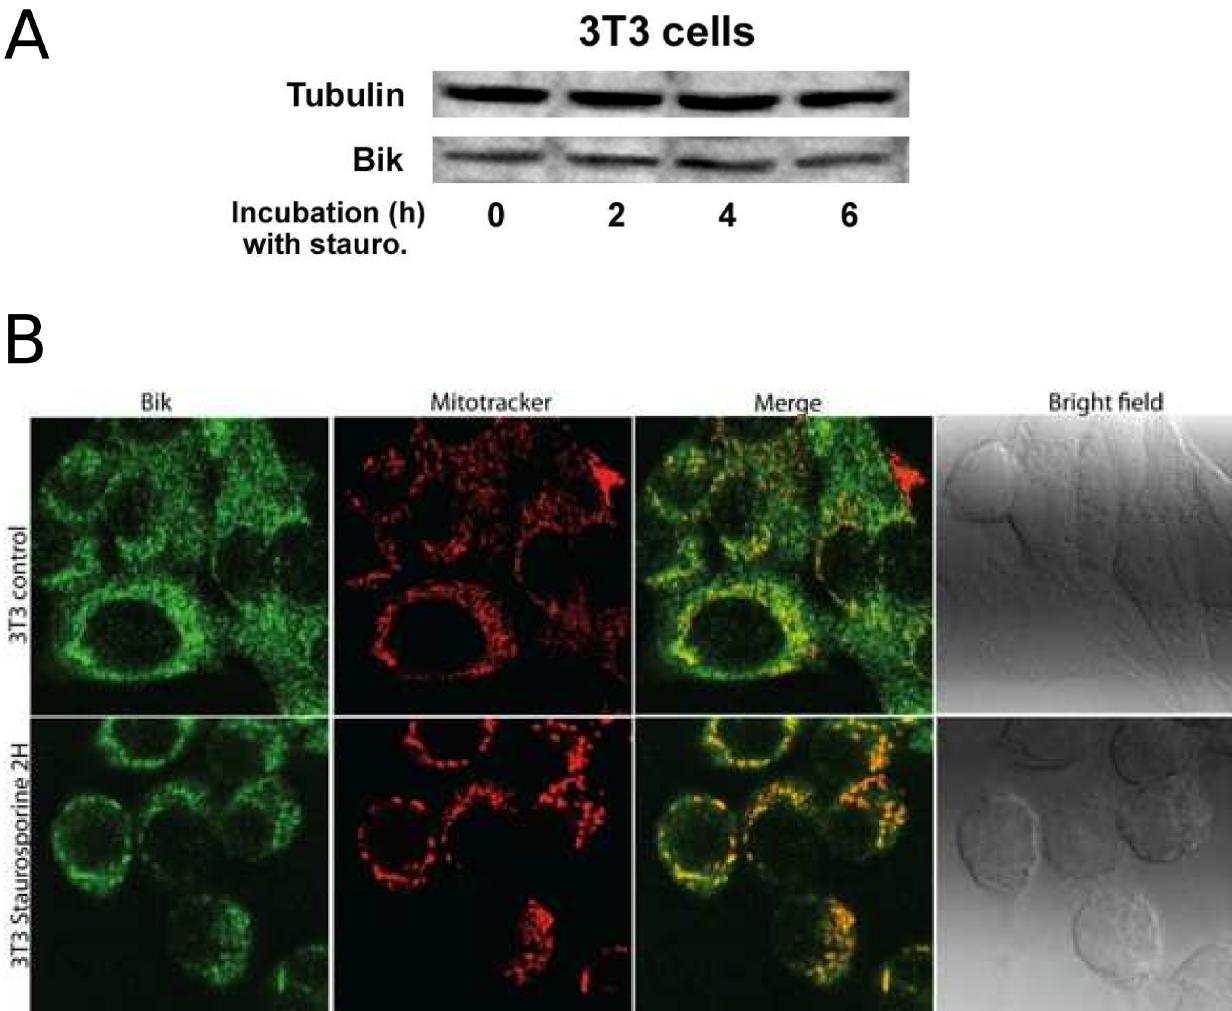
Src-transformed cells (nM)